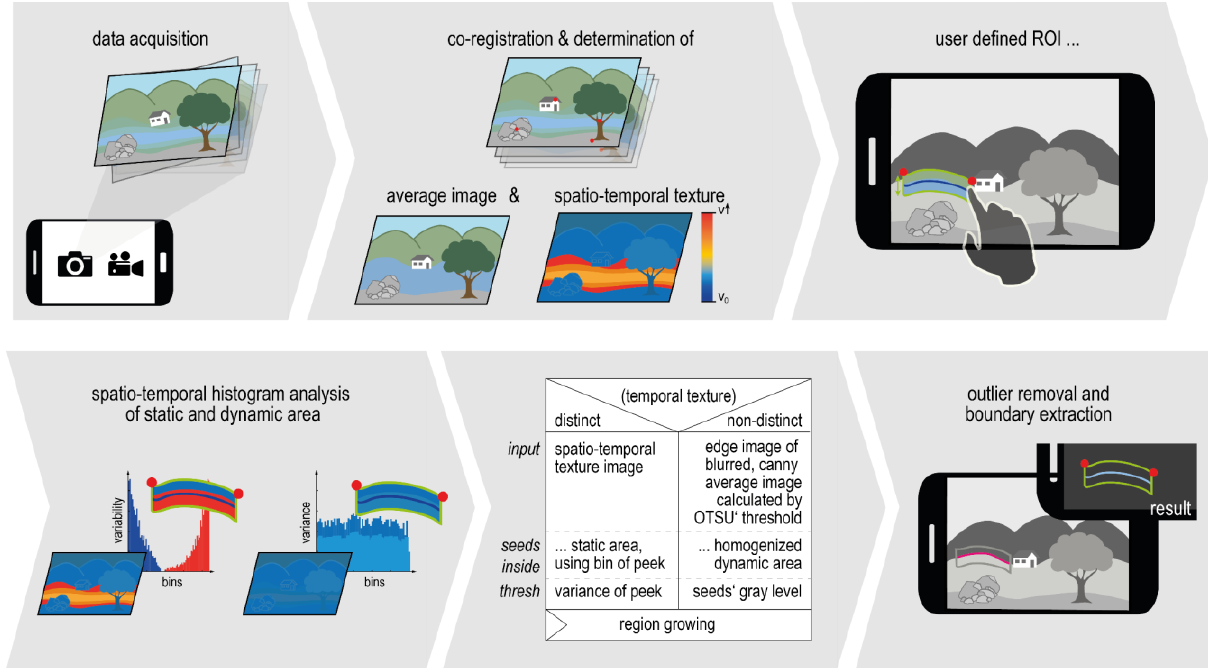
Figure 3. Process pipeline from data acquisition to result display.